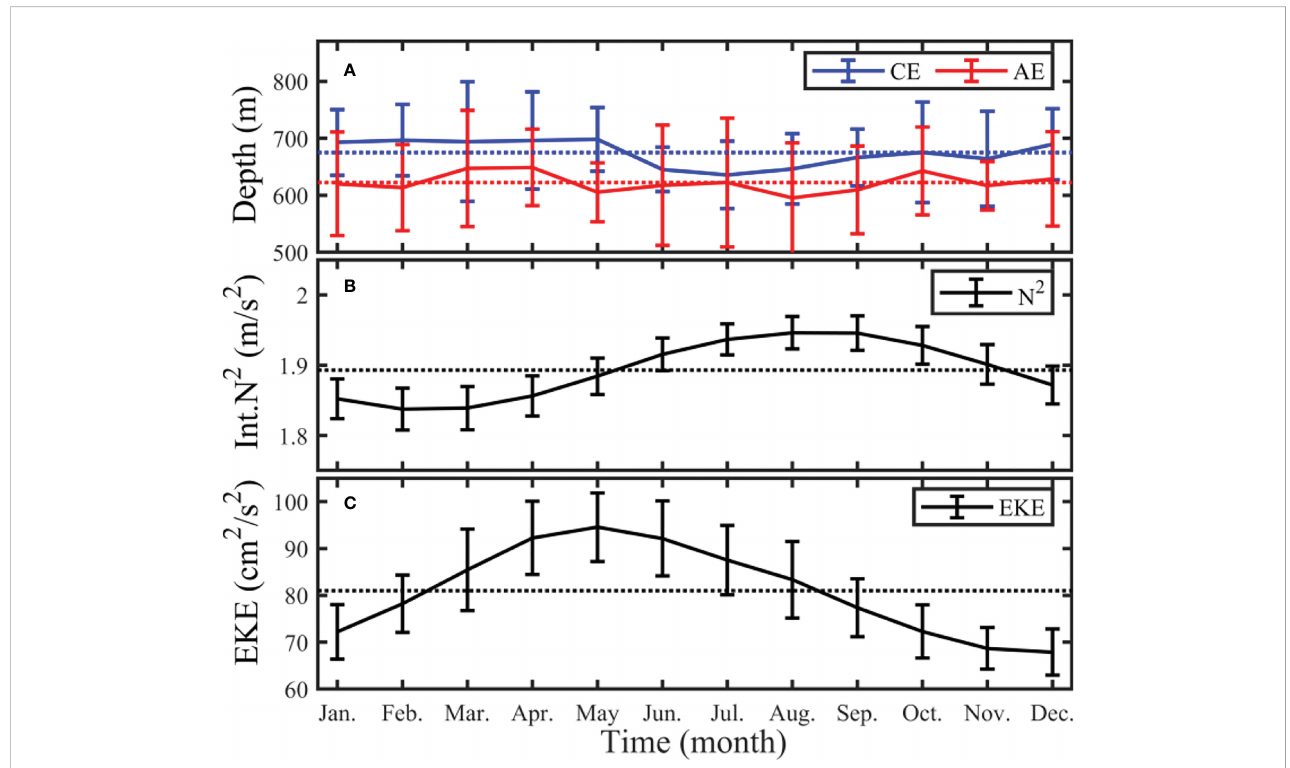
FIGURE 8 Monthly distribution of multi-year (2008 ~ 2017) average eddy penetration depths (A) , integrated strati fi cation (B) , and eddy kinetic energy (C) in the STCC area. Blue and curves represent cyclonic eddy and anticyclonic eddy, respectively. The corresponding vertical lines on each curve represent the standard deviation, and the dotted line represents the multi-year average